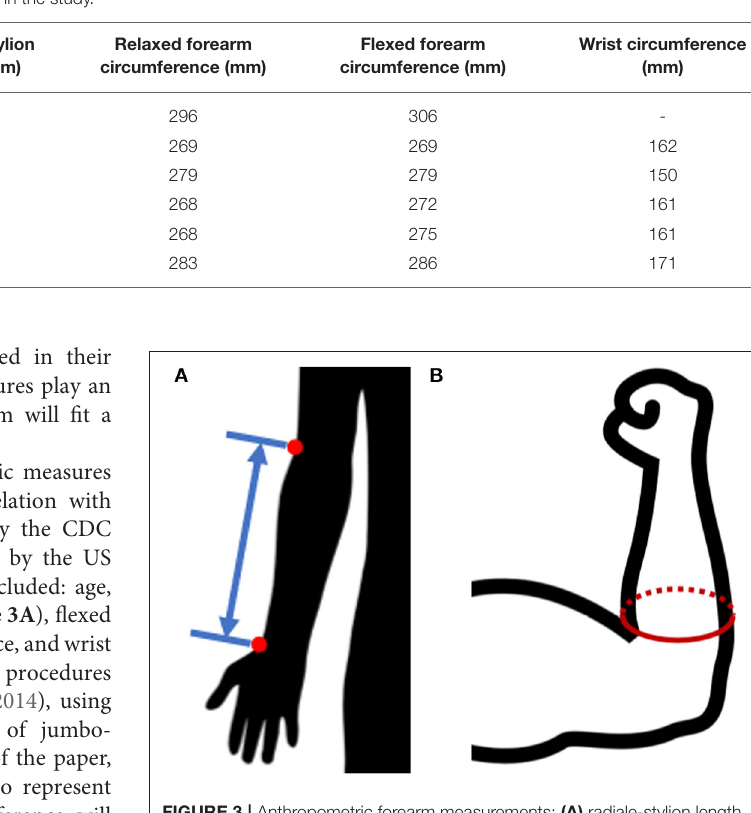
produce a set of ellipse parameters ( Figure 4B ) at each slice that can be used to recreate a 3D surface of forearm geometry ( Figure 4C ). Ellipse parameters were normalized, curve-fit with 3rd-order polynomials as a function of axial distance from the radiale